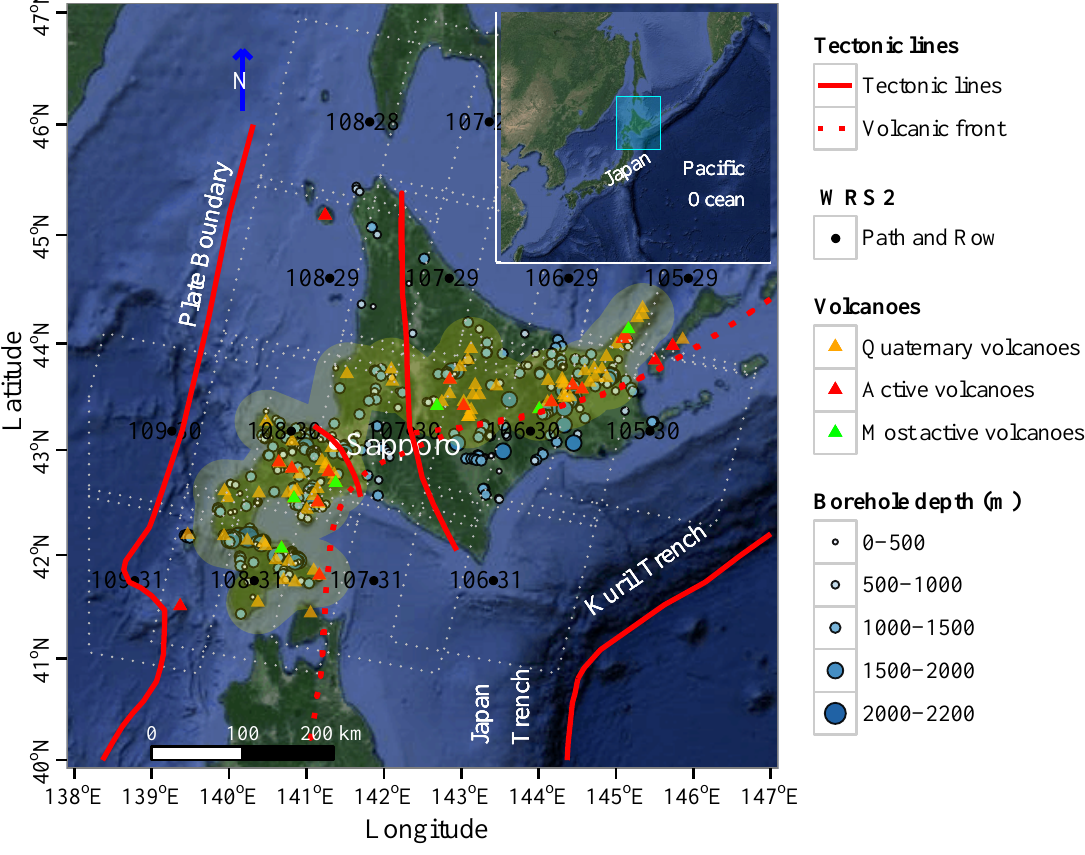
Figure 1. Location of study area, Hokkaido in northern Japan, and distribution of drilling sites for temperature logging, most active, active and quaternary volcanoes, tectonic lines and volcanic front. Frames of Landsat series scenes used for this study (white dotted rectangles) are overlaid on the map with path and row numbers by Worldwide Reference System 2